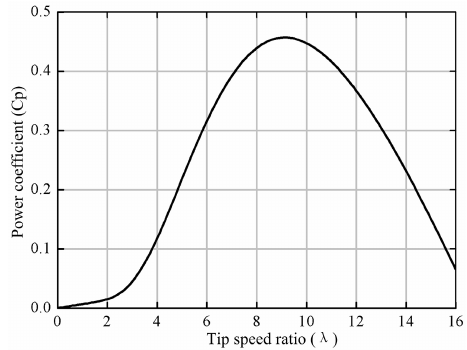
Figure 3. The curve of the power coefficient versu the tip speed ratio.